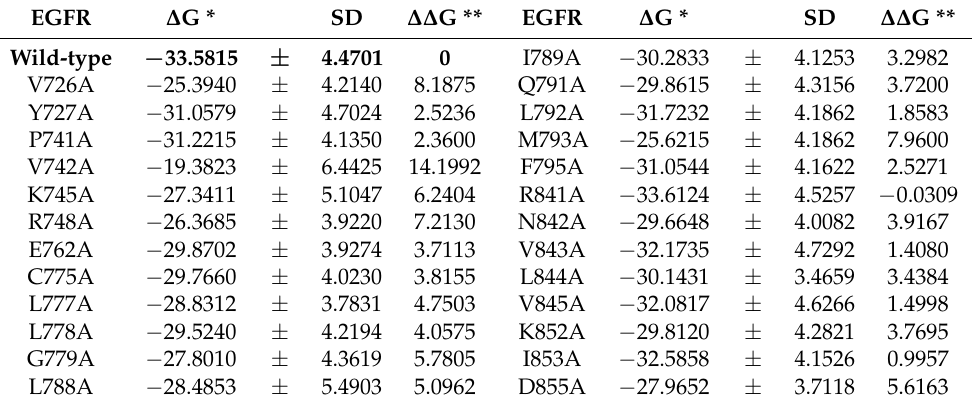
Table 3. Binding free energy (kcal/mol) of erlotinib to the wild-type and mutated EGFR TK. EGFR ∆ G * SD ∆∆ G